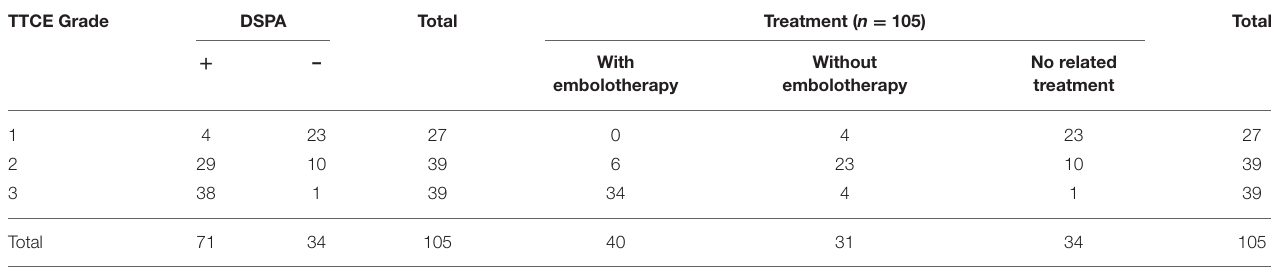
TABLE 4 | DSPA results and treatments in different TTCE grade. TTCE Grade DSPA Total Treatment ( n = 105) Total